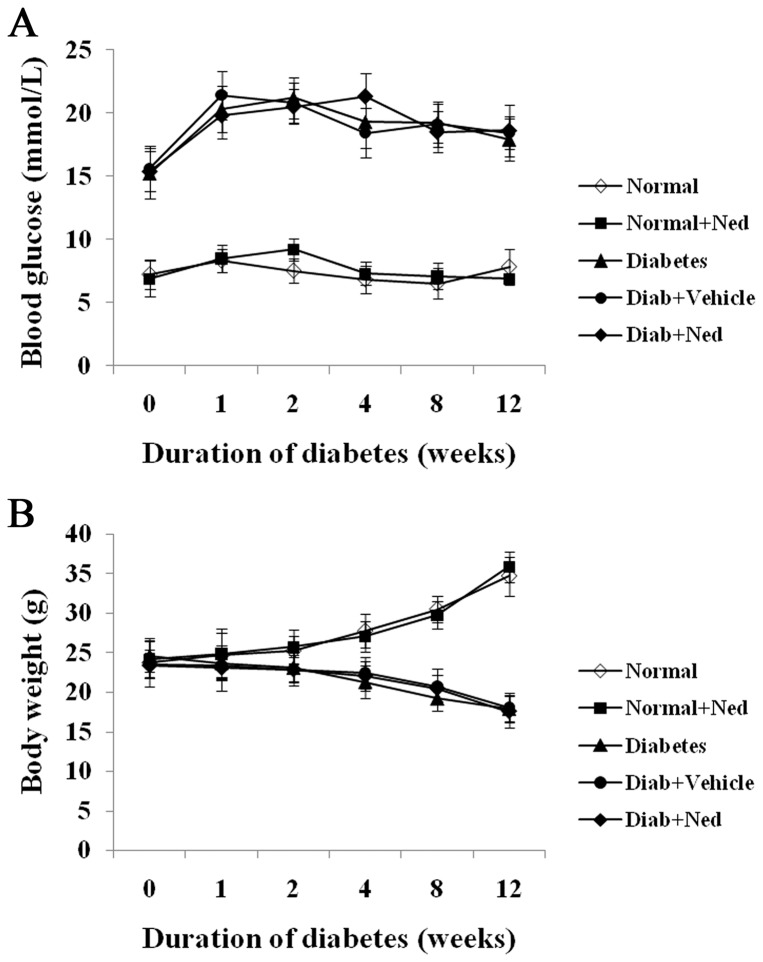
The blood glucose level and body weight of normal and STZ-induced diabetic mice were monitored for 12 weeks after nedocromil (Ned) treatment, as described in Methods.(A) The blood glucose levels of the different treatment groups at the indicated time points. (B) The body weights of the different treatment groups at the indicated time points. (n = 15 per group).